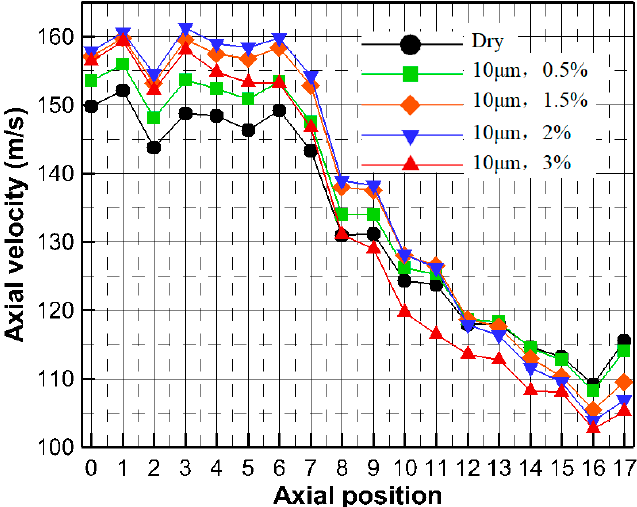
Energies 2018 , 11 , x FOR PEER REVIEW 27 of 29 Figure 33. Axial variation of axial velocity under injecting water of different droplet sizes.